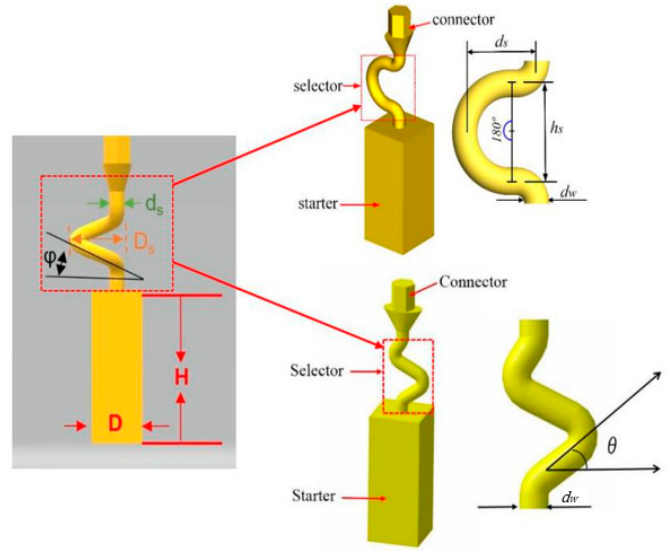
Figure 1. Illustration of the dimensional reduction method with a 2D selector. (d w : wire diameter, d s : eccentric distance, h s : pitch length, θ : take-off angle).